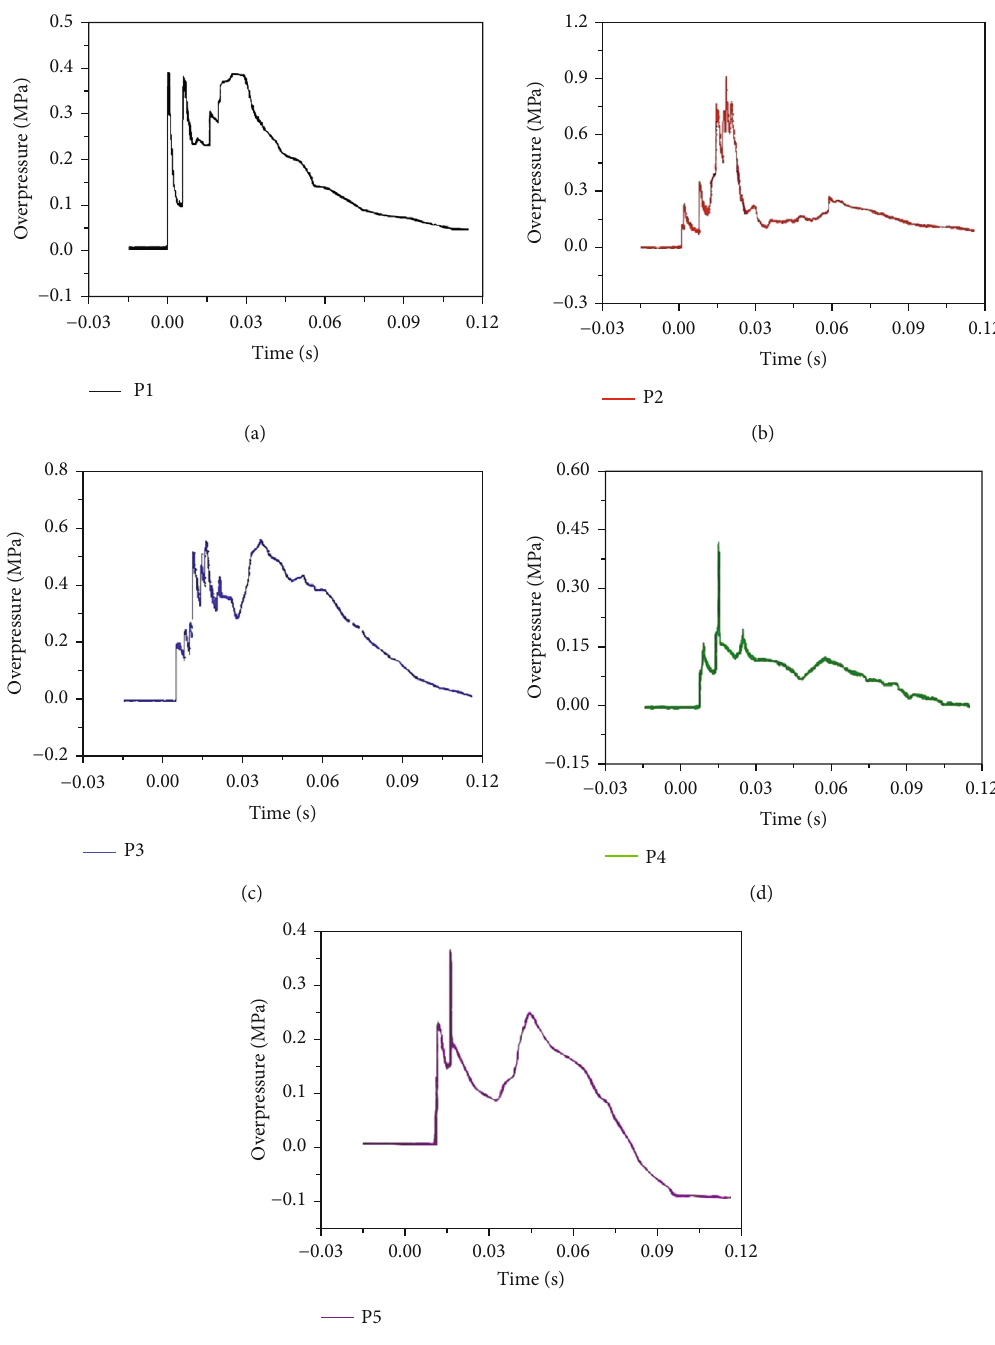
Figure 5: Overpressure-time curve of gas explosion ( α = 60 ° , V = 0 : 28m 3